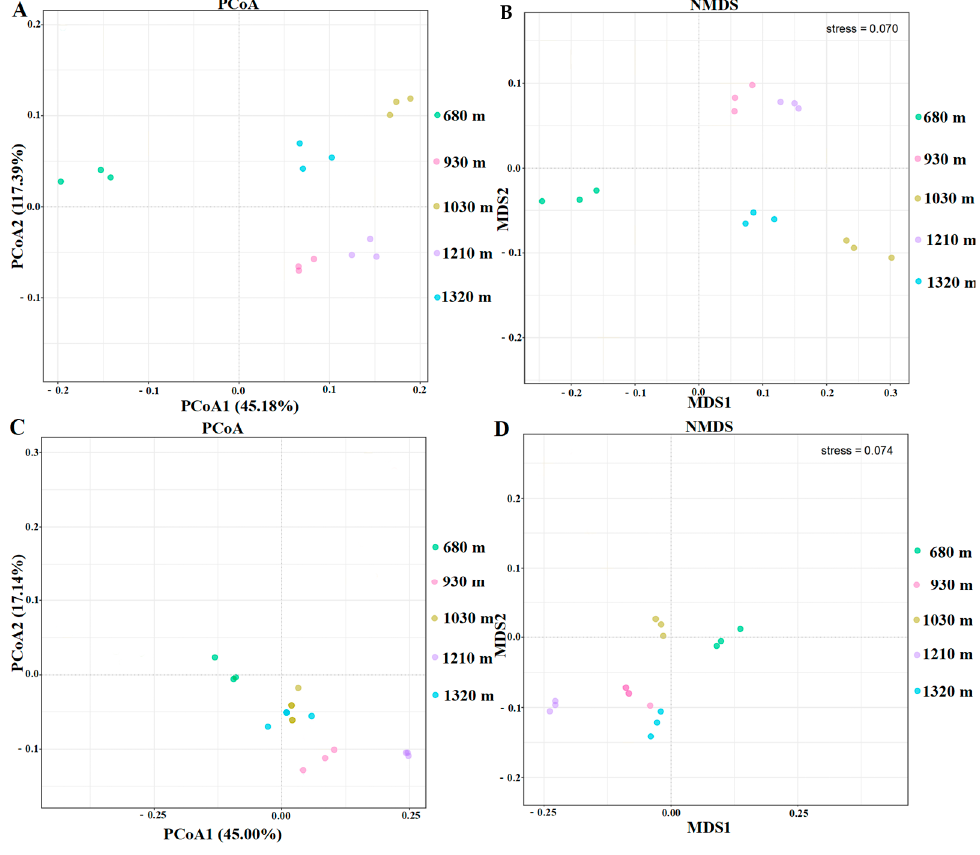
Figure 7. Principal coordinate analysis (PCoA) and nonmetric multidimensional scaling (NMDS) analysis of the bacterial and fungal communities in the C. arabica rhizospheric soil samples at different altitudes. ( A ) PCoA of the bacterial community. ( B ) NMDS analysis of the bacterial community. ( C ) PCoA of the fungal community. ( D ) NMDS analysis of the fungal community. Data are presented for the rhizospheric soil samples collected at altitudes of 680, 930, 1030, 1210, and 1320 m.